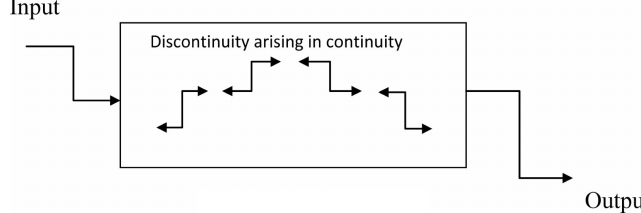
Figure 1. Scheme of the hybrid systems.